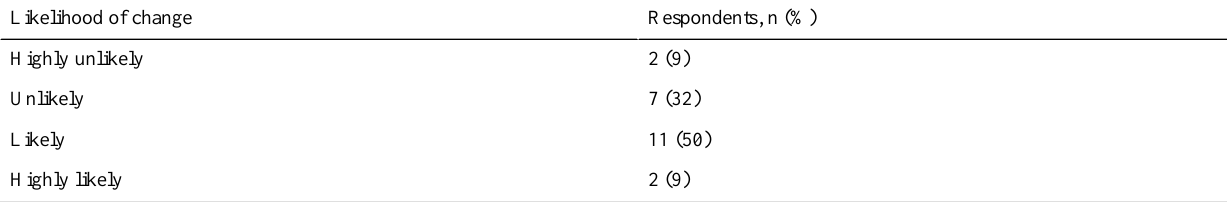
Table 3. Participants’self-reported likelihood of change in their clinical practice.